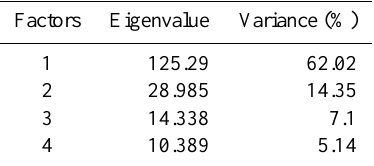
Table 2. The factors resulted from a CABFAC factor analysis with varimax rotation performed on foraminiferal counting data for species contributing by > 5% to the assemblages in at least one